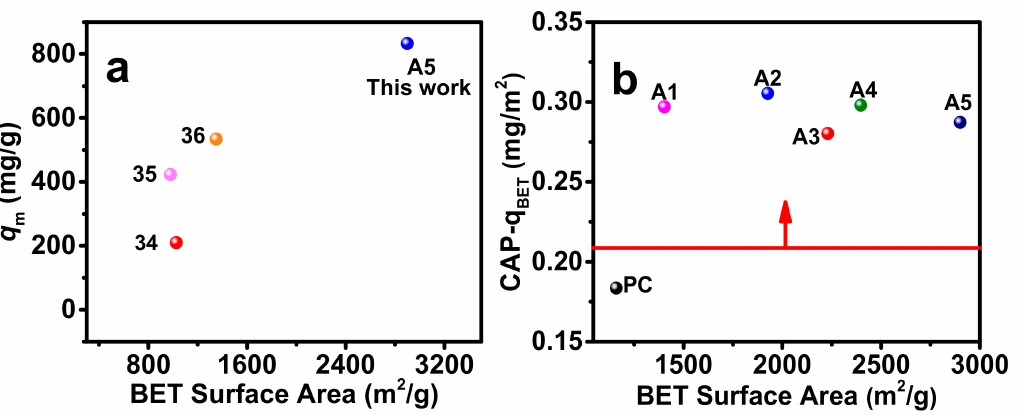
Figure 5. ( a ) Adsorption capacity ( q m ) of CAP versus BET surface area, plotted for previously reported materials and the materials prepared in this study, ( b ) BET surface area of selected NSC material versus CAP-q BET . q BET = q m/BET surface area, suggesting CAP adsorption capacity per BET surface area. PC: porous carbon material activated with K 2 CO 3 , activation temperature = 700 ◦ C, K 2 CO 3 : biomass mass ratio = 1:1.